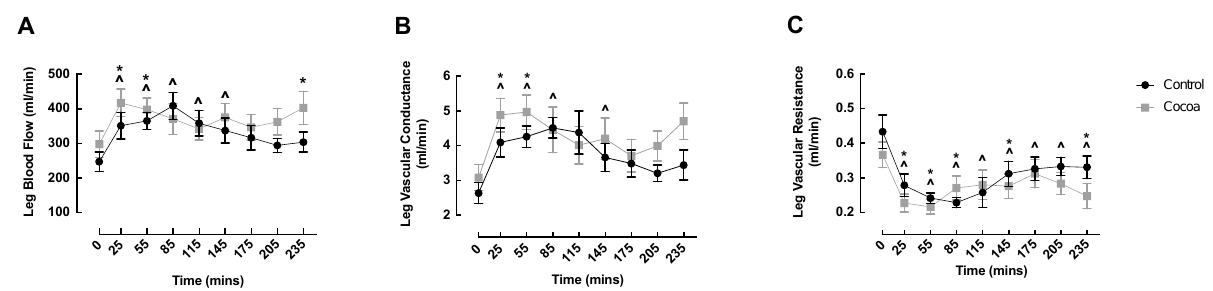
Figure 2. Cocoa did not enhance oral nutritional supplement feeding-induced changes in leg blood flow ( A ), vascular conductance ( B ) or vascular resistance ( C ) of healthy older adults. ^ denotes significant within condition difference from control baseline ( p < 0.05); * denotes significant within condition difference from cocoa baseline ( p < 0.05).